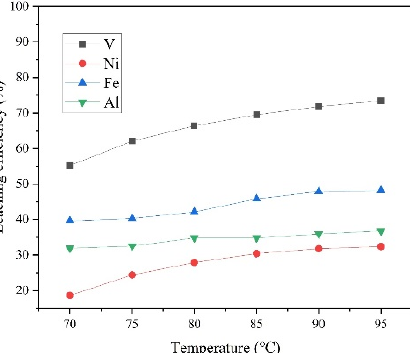
Figure 7. Effects of leaching temperature on leaching efficiency of V and Ni (t = 240 min; T = 95 °C ; D50 ≤ 17.34 μ m).